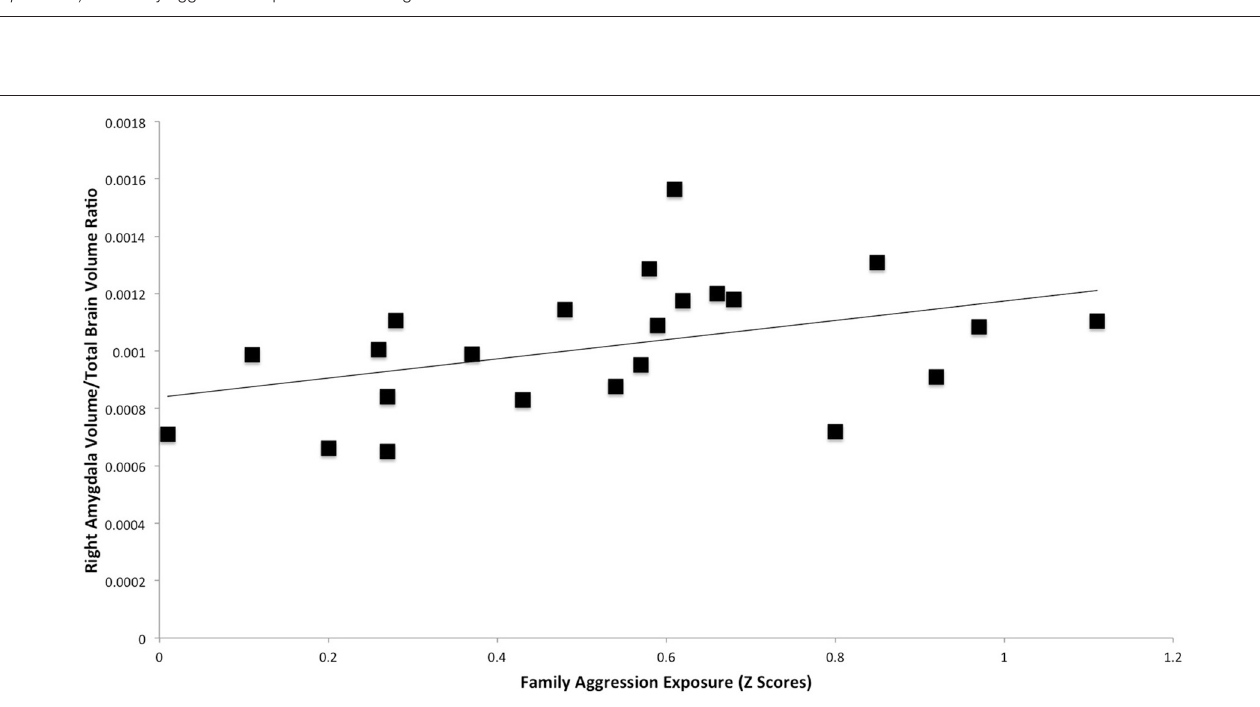
FIGURE 2 | Results of a partial correlation representing the relationship between family aggression exposure and bilateral hippocampal volume measured by FSL segmentation. A significant negative correlation was found between bilateral hippocampal volume (left: β = − 0.75, p < 0.001; right: β = − 0.48, p < 0.05) and family aggression exposure accounting for total brain volume.